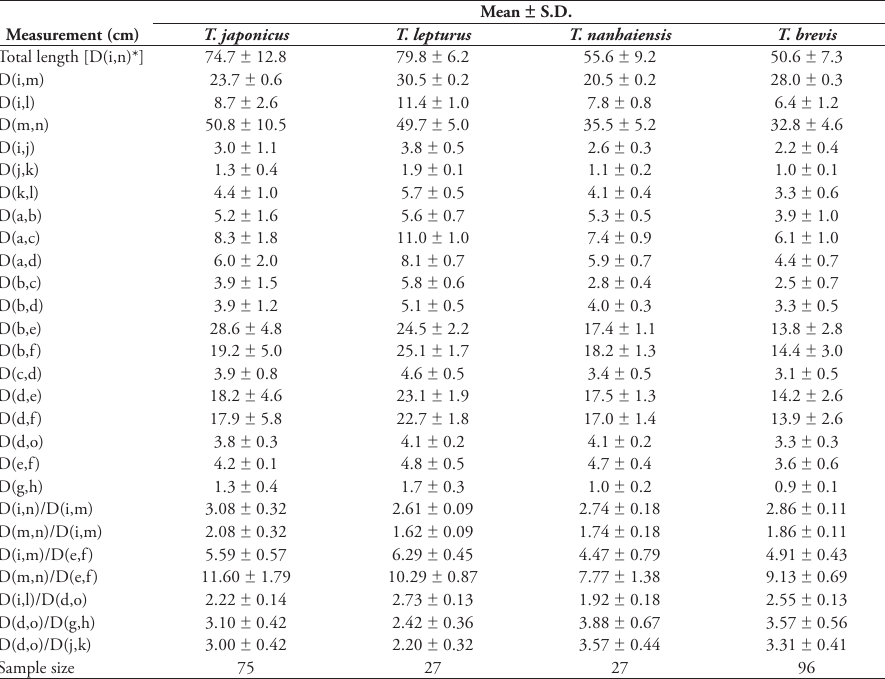
Table 3. Summary statistics of body measurements for four Trichiurus species. Measurement